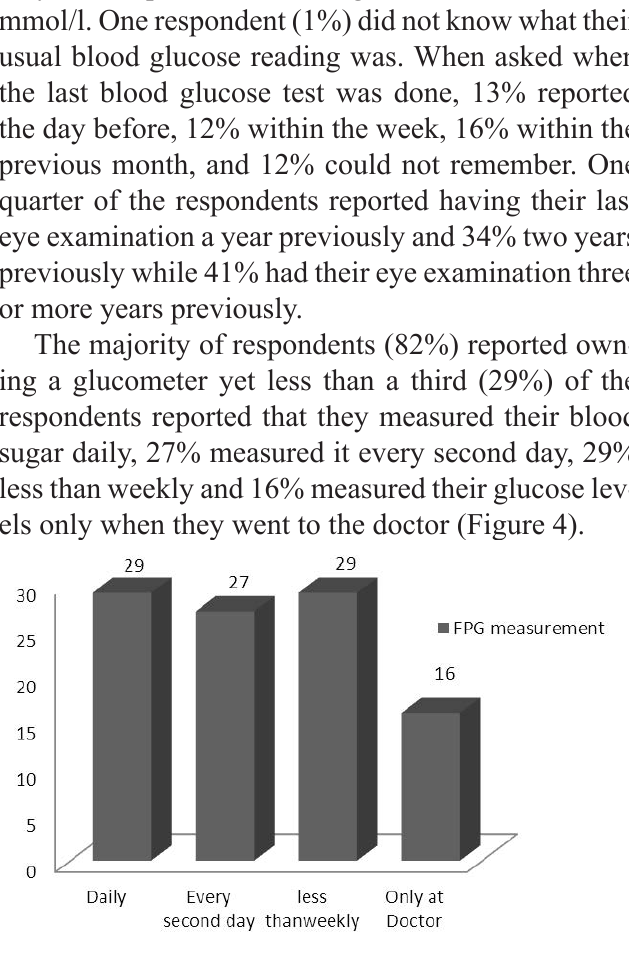
Figure 4: Patient testing of Fasting Plasma Glucose